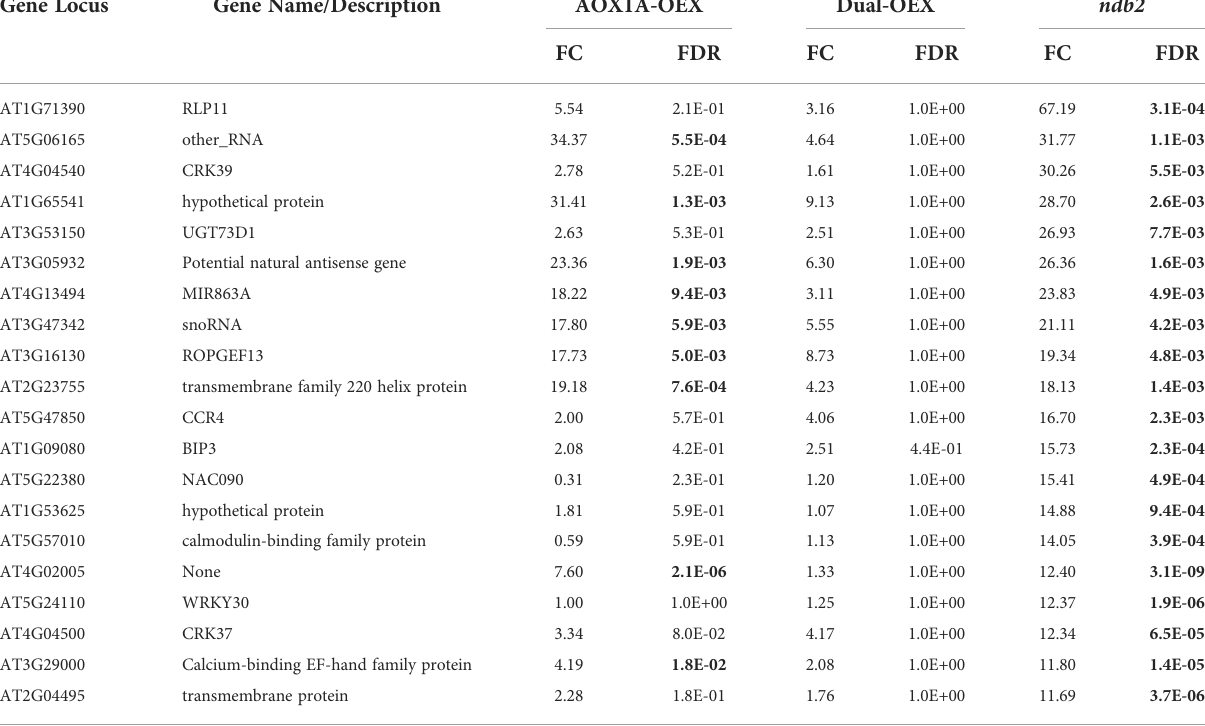
TABLE 3 Top 20 up-regulated DEGs for NDB2 knockout line relative to wild type. Gene Locus Gene